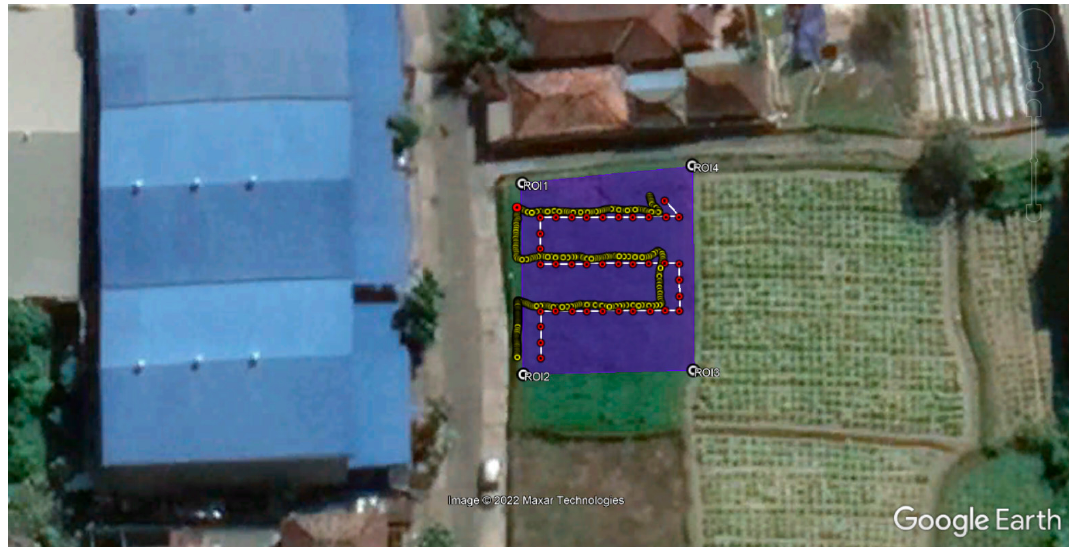
Figure 14. Data visualization on GPS navigation. Table 4. Comparison of plowing process time between simulation results and field trials.